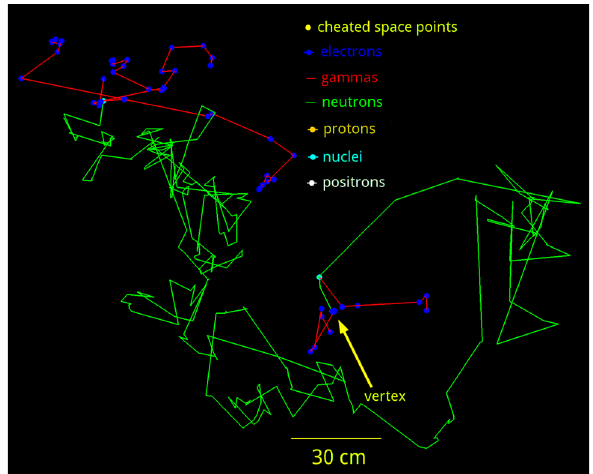
Fig. 5 Visualization of an example MARLEY ν e CC event simulated in LArSoft, showing the trajectories and energy deposition points of the interaction products